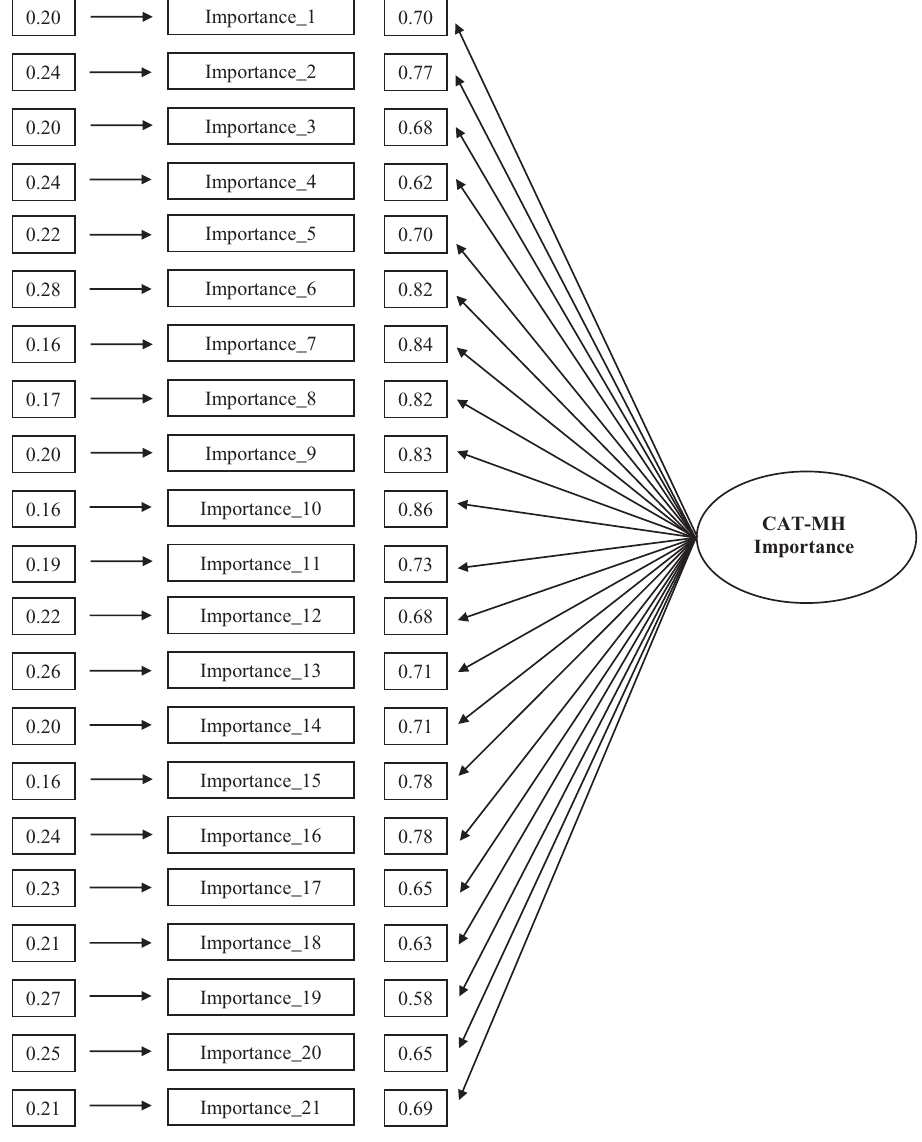
Figure 1. Confirmatory factor analysis (The Section on Importance of Skills and